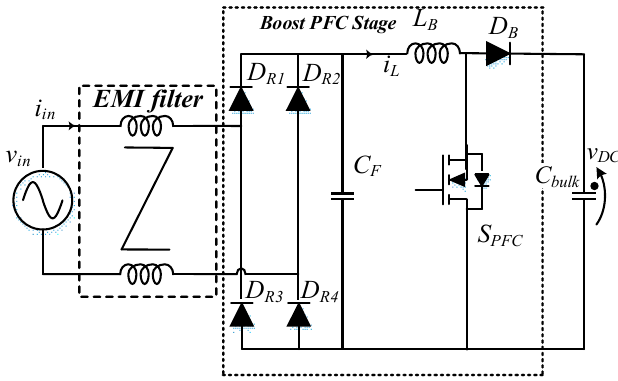
Figure 2. Boost power factor correction (PFC) stage.